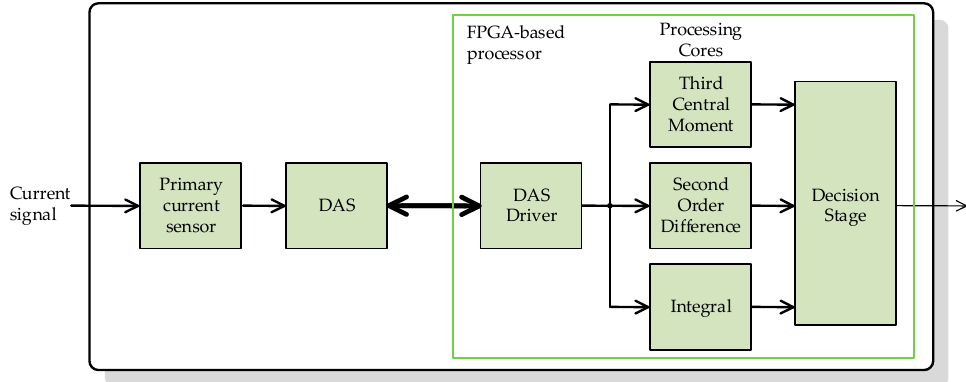
Figure 6. Architecture of the proposed smart